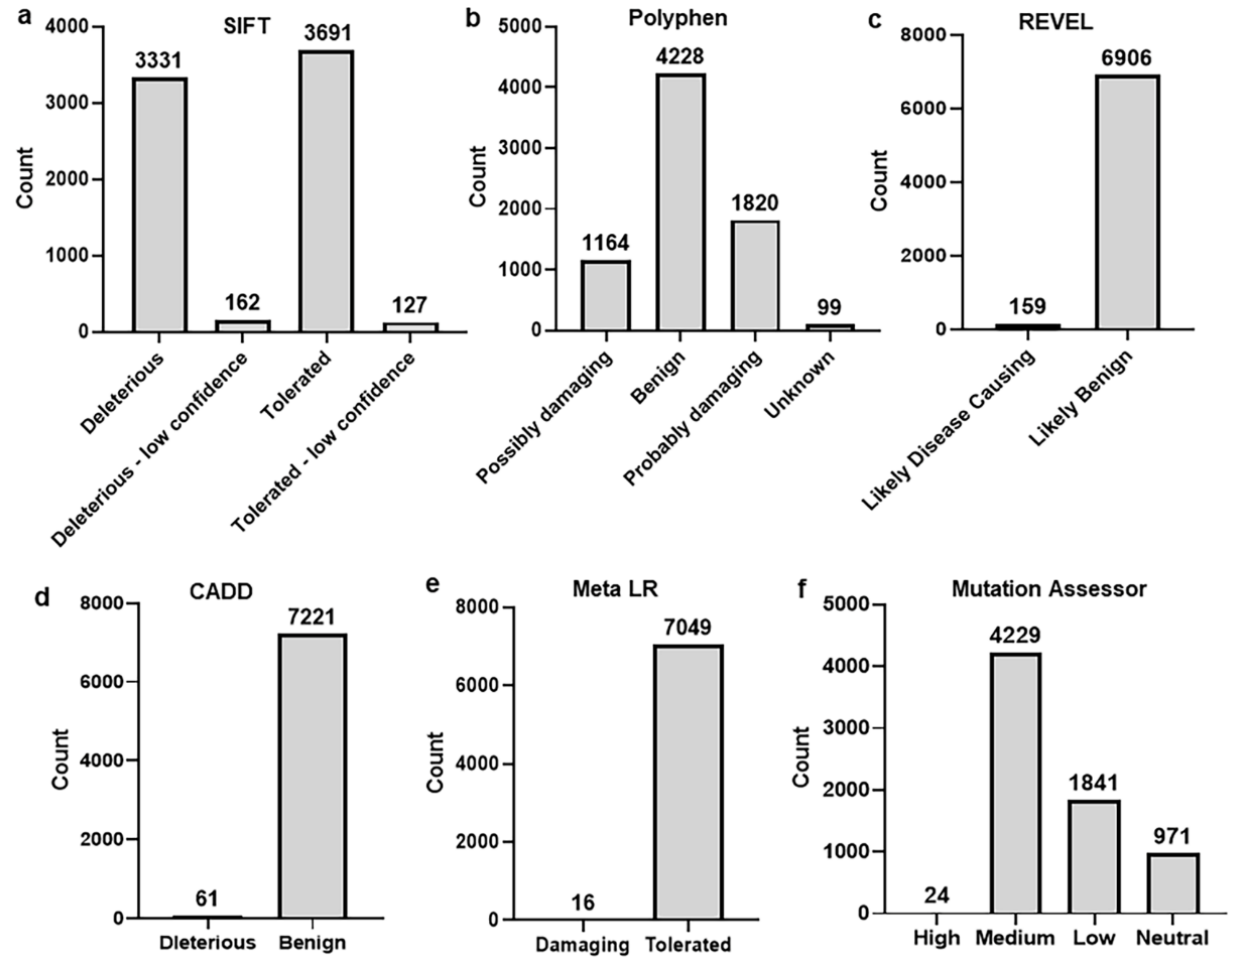
Figure 2. Sorting of nsSNPs using six different algorithms : ( a ) SIFT, ( b ) Polyphen2, ( c ) Reval, ( d ) CADD, ( e ) Meta LR, ( f ) Mutation assessor. Table 1. List of CARD14 nsSNPs genotyped in this study.